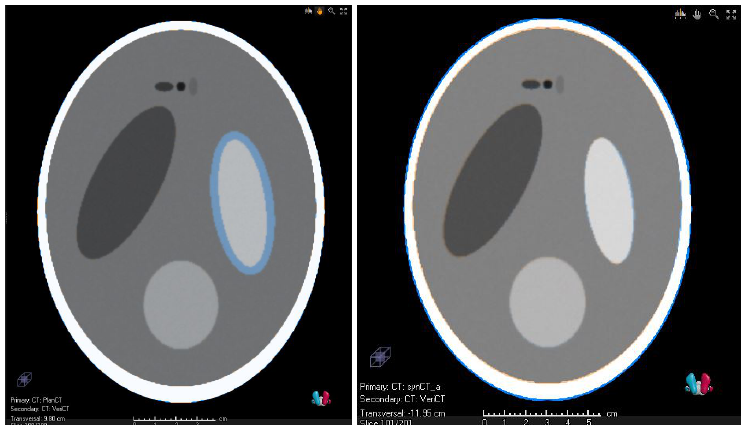
Figure 3. Transversal CT slices concerning the validation with the Shepp–Logan phantom. ( Left ) reference CT and verification CT. They differ with respect to the tumor volume. This is indicated by the blue ring, which indicates higher CT values of the reference CT. ( Right ) Overlay of the synthetic CT and the verification